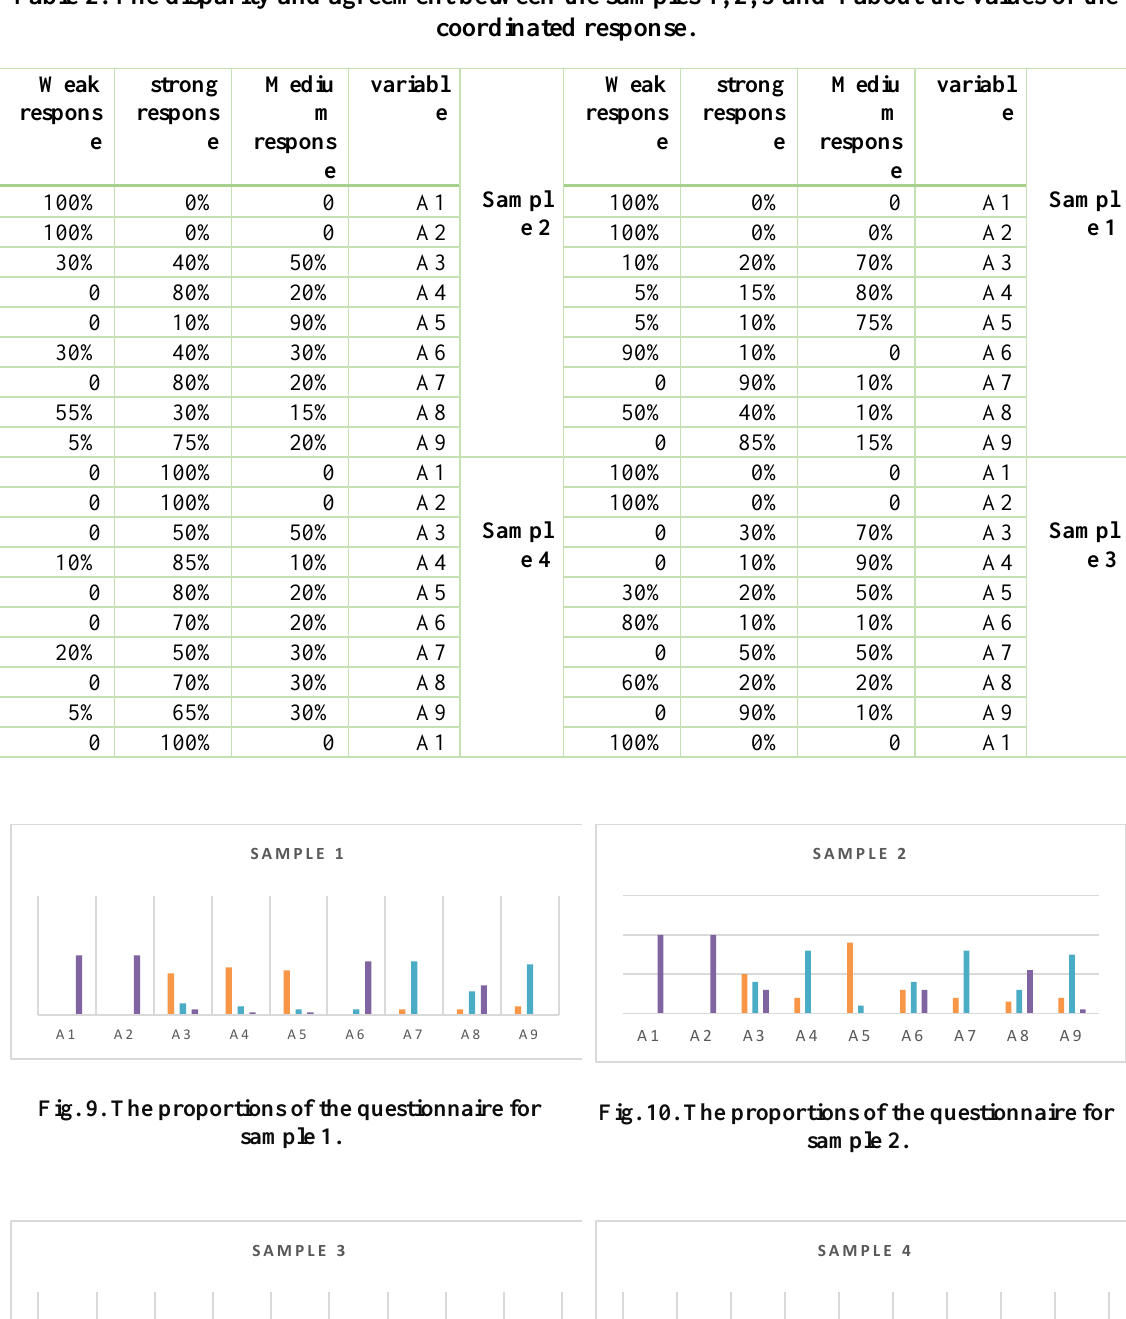
Table 2. The disparity and agreement between the samples 1, 2, 3 and 4 about the values of the coordinated response.